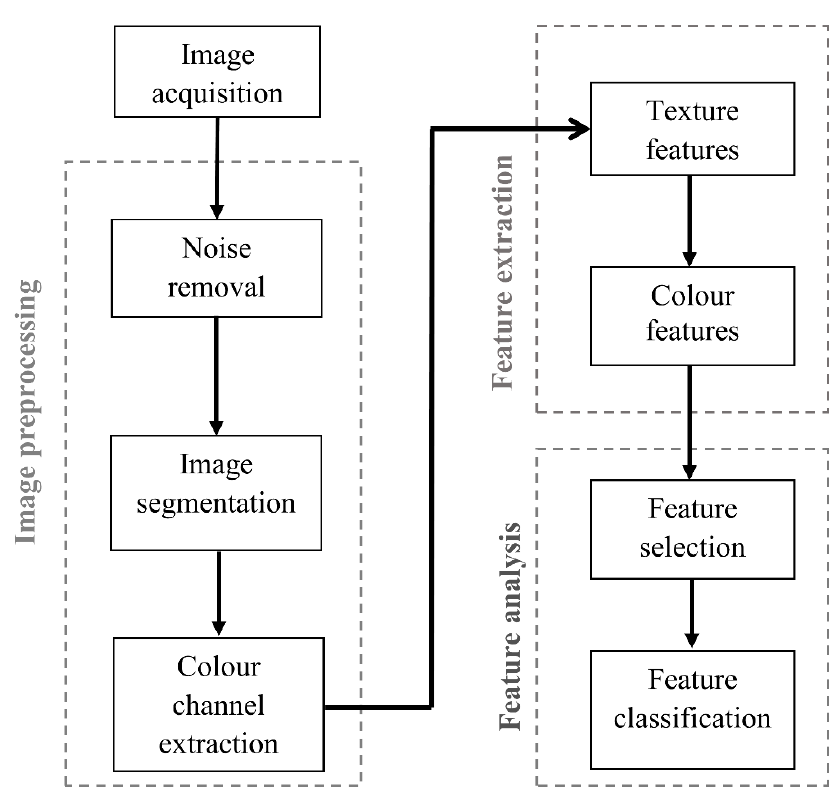
Figure 2. The flowchart of the machine vision